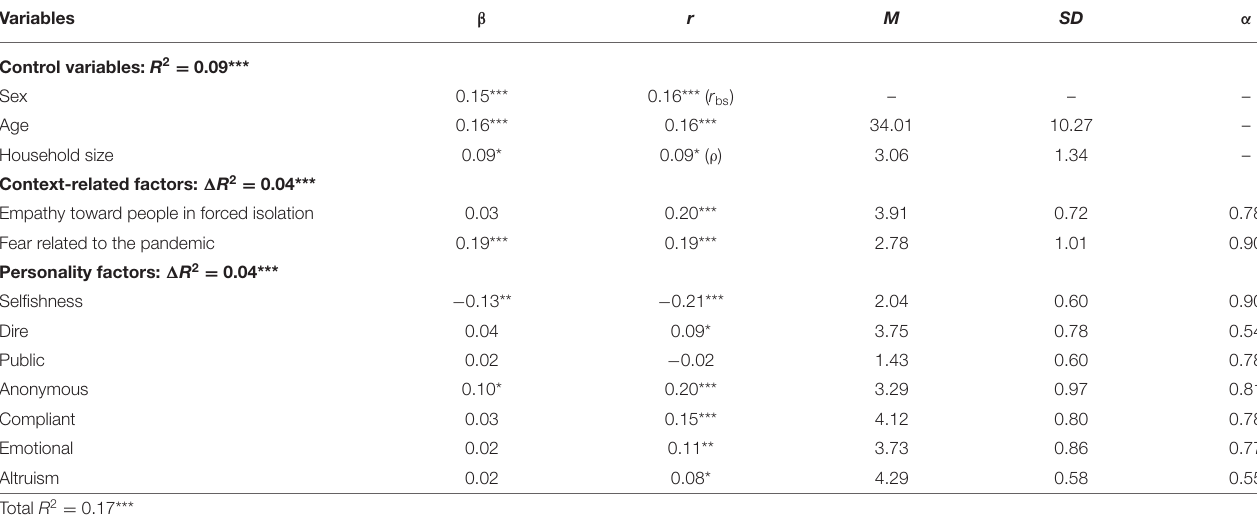
TABLE 1 | Contributions of demographics, context-related, and personality factors to COVID-19 protective behaviors and correlations. Variables